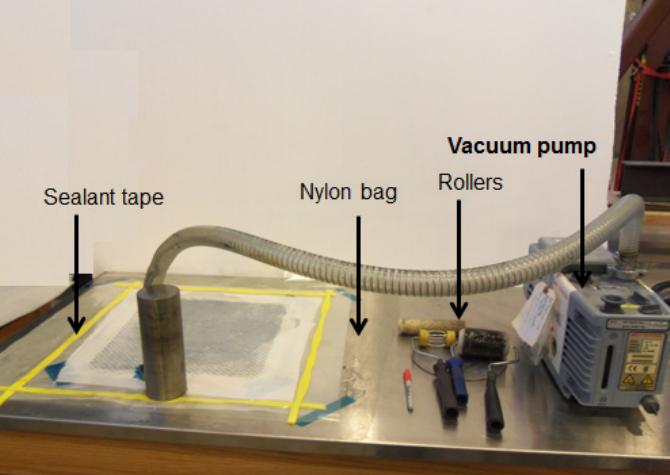
Figure 3. GFRP fabrication using vacuum hand lay-up technique.